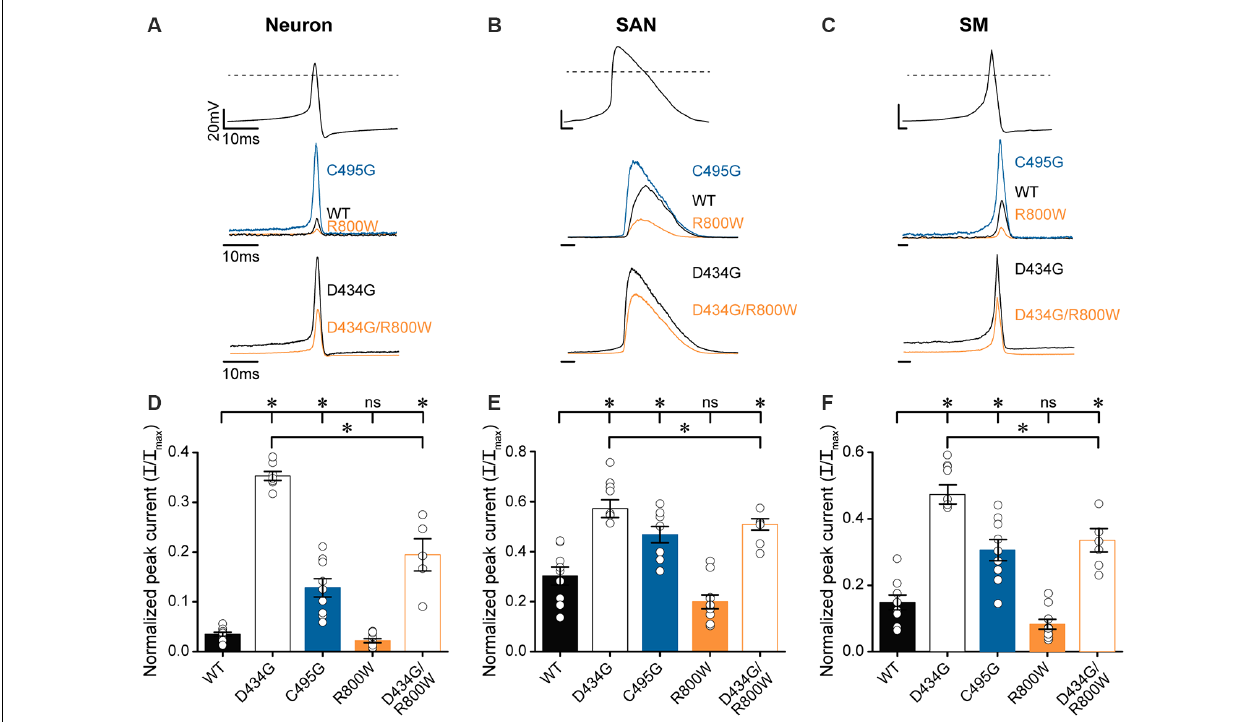
FIGURE 7 | Effects of SNP substitutions on BK currents evoked by physiological stimuli. Action potential (AP)-evoked currents were recorded from WT and SNP-containing hBK VYR channels in physiological K + at 10- µ M Ca 2 + . (A–C) Waveforms for Neuron (A) , SAN (B) , and SM (C) AP voltage command protocols (top traces) used to elicit BK currents from WT, D434G, C495G, R800W, and D434G/R800W channels (bottom traces). Current amplitudes are normalized to the maximum outward current evoked by the voltage step protocol in Supplementary Figure S2A . (D–F) Normalized peak AP-evoked BK current amplitudes from WT and SNP-containing channel variants activated by Neuron (D) , SAN (E) , and SM (F) voltage commands. Currents were significantly larger than WT for Neuron (D434G, P < 0.0001; C495G, P < 0.0001; D434G/R800W, P < 0.0001), SAN (D434G, P < 0.0001; C495G, P = 0.002; D434G/R800W, P = 0.0002), and SM (D434G, P < 0.0001; C495G, P = 0.0002; D434G/R800W, P < 0.0001) waveforms. D434G/R800W currents were reduced compared with D434G for Neuron ( P < 0.0001), SAN ( P = 0.02), and SM ( P < 0.0001) waveforms. ∗ P < 0.05, one-way ANOVA with Bonferroni post hoc test for significant differences between all current amplitudes for each AP command. ns, not significant; N = 6–11 recordings per